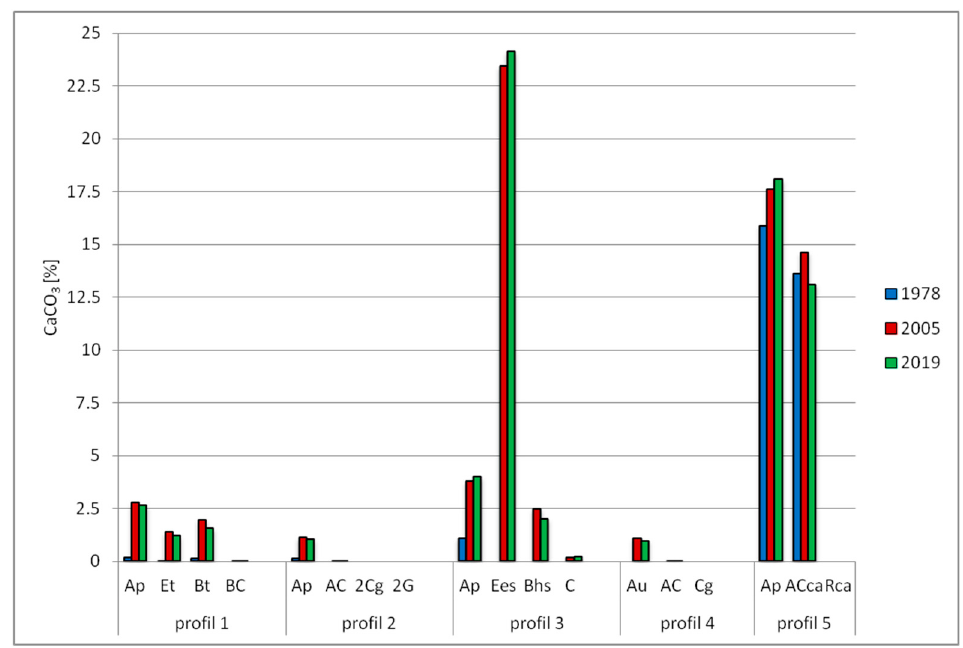
Figure 5. Dynamics of CaCO 3 (%) content in individual horizons of the analysed soils between 1978 and 2019.